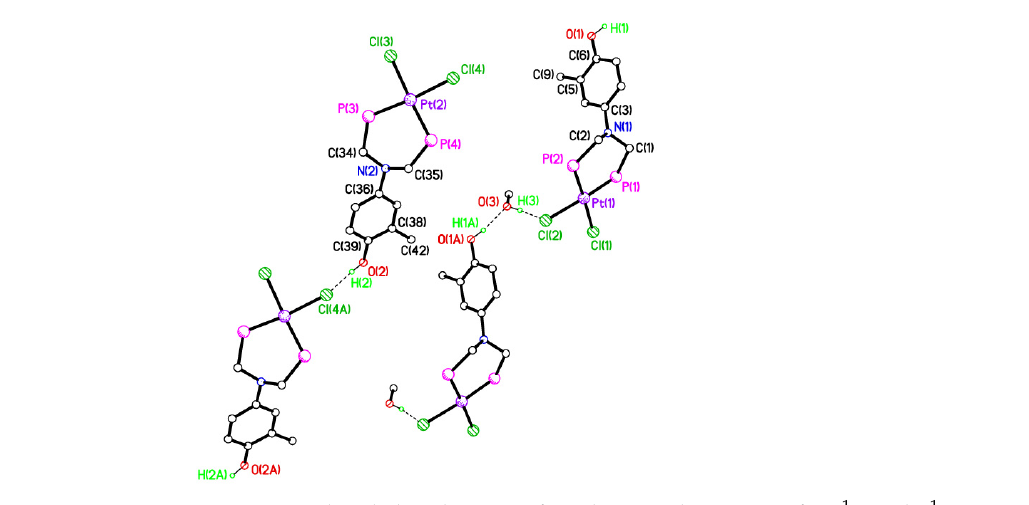
Figure 10. H-bonded packing motifs in the crystal structure of 4e ∙ ½CHCl 3 ∙ ½CH 3 OH. Most H atoms, two Ph groups per P atom, and the disordered chloroform of crystallisation which is not involved in any significant intermolecular interactions, are omitted for clarity. Symmetry operators are x, y − 1, z and x, y + 1, z. In 5c , the amide and ring atoms from C(4) > C(11) are disordered over two sets of